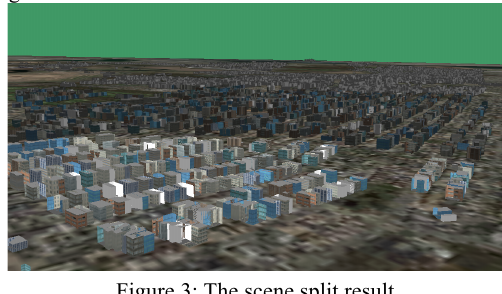
Figure 3: The scene split